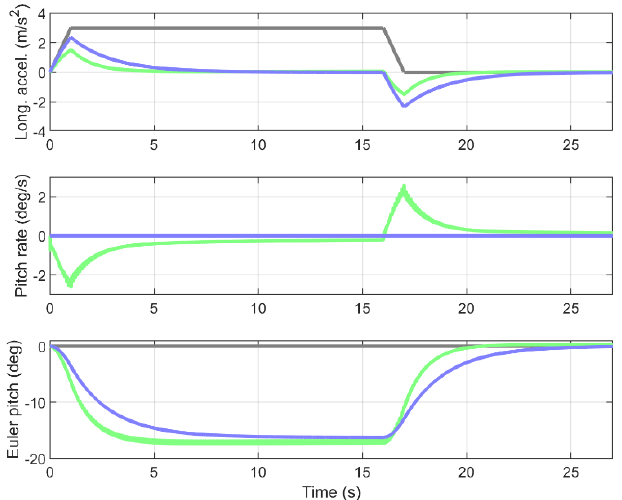
Figure 2. Output of the SOMS model (blue lines) and the Observer model (green lines) in response to a stepwise increase in longitudinal acceleration (gray line in upper panel) representative of a “static” takeoff run, where the engines are set at takeoff thrust with the brakes on and the aircraft starts to accelerate as soon as the brakes are released. The upper, middle, and lower plots show, respectively, longitudinal acceleration, pitch rate, and Euler pitch angle.